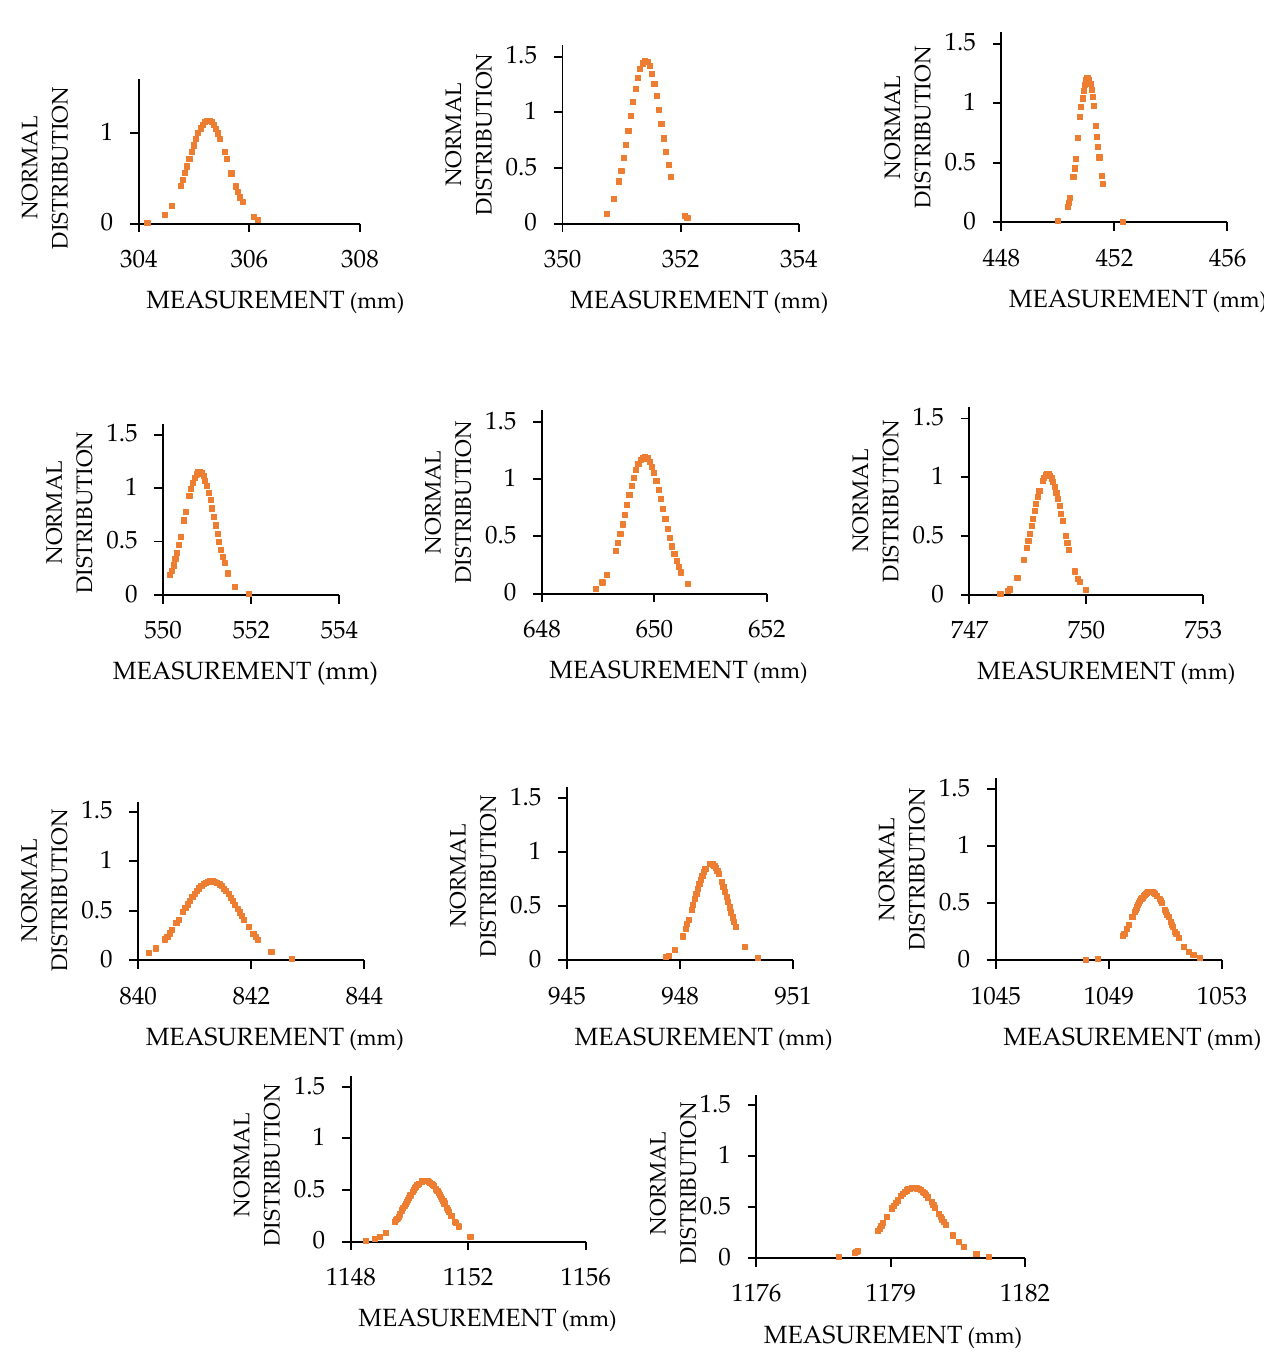
Figure 16. The normal distribution function of HC-SR04 for various distance measurements.